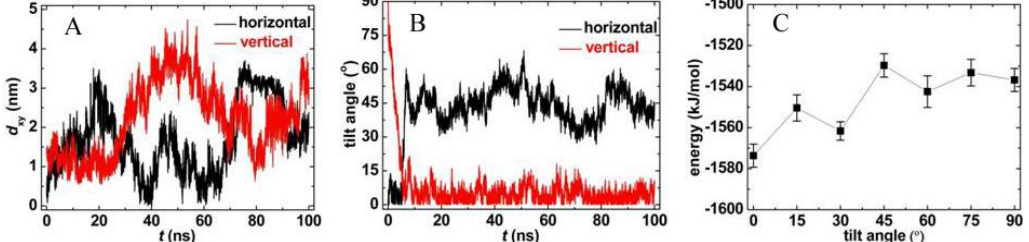
Figure 2. The location ( A ) and orientation ( B ) of PCNT in the membrane, and ( C ) the interaction energies at fixed tilt angles.